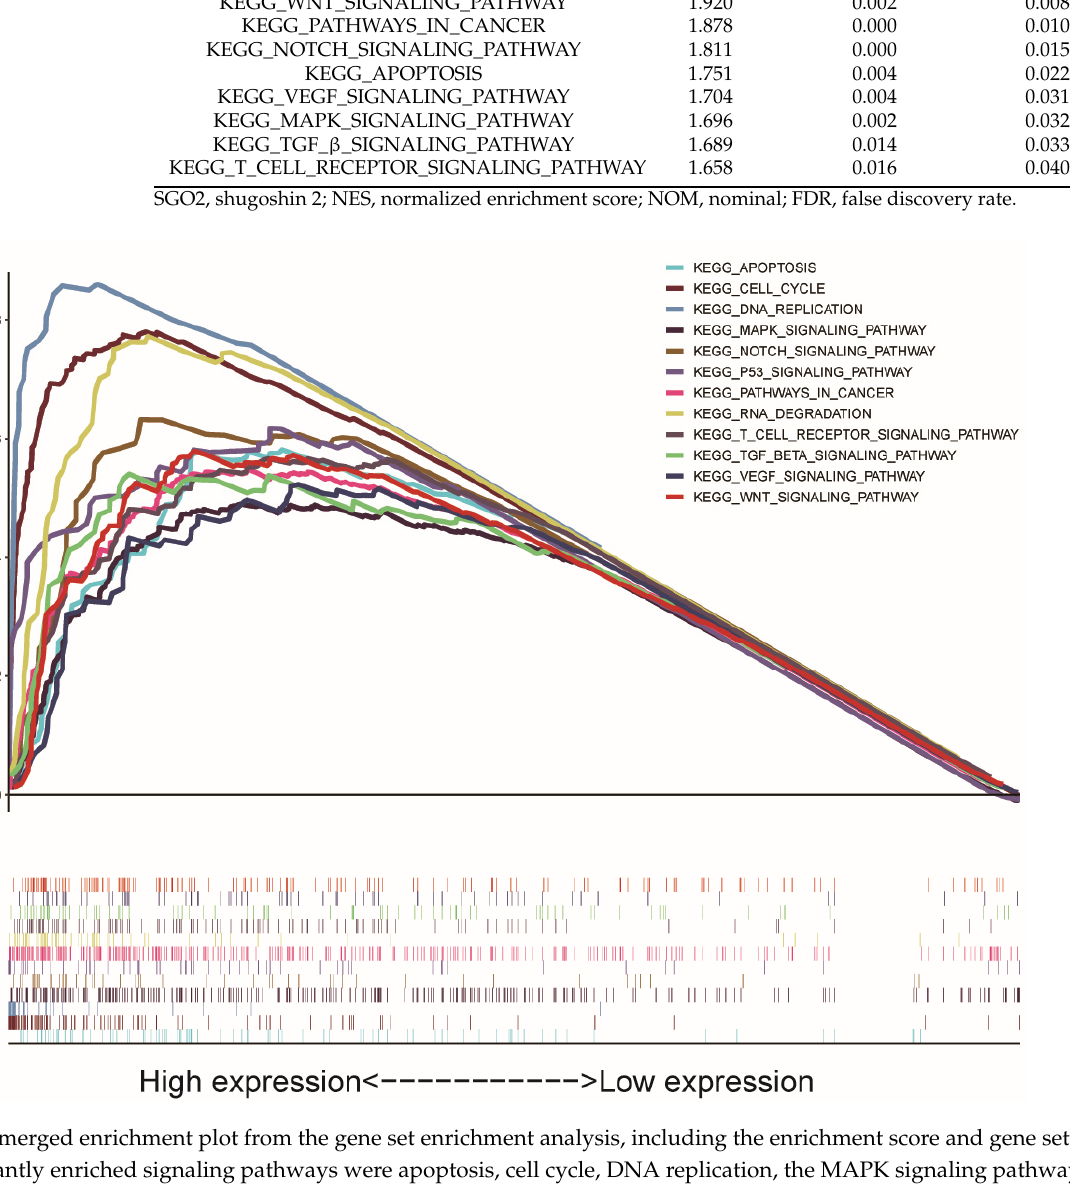
Table 5. Gene sets enriched in the high SGO2 expression phenotypes.